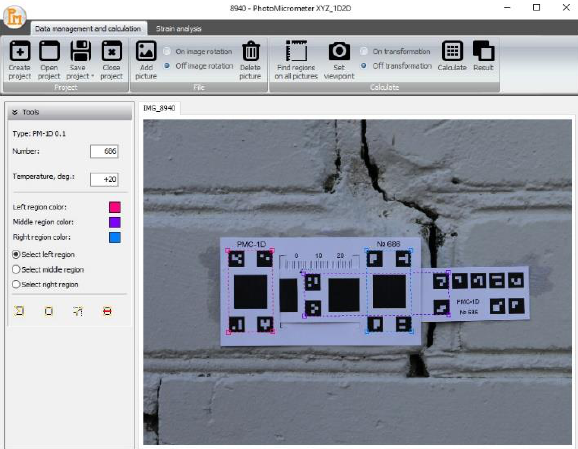
Figure 5. The Interface of the PhotoMicrometer C software. - automatic identification of the marker number, automatic recognition of C 1 -C 4 measuring areas using the position of Aruco marks; - binarization of the C 1 -C 4 measuring areas image and counting the number of black pixels in each area